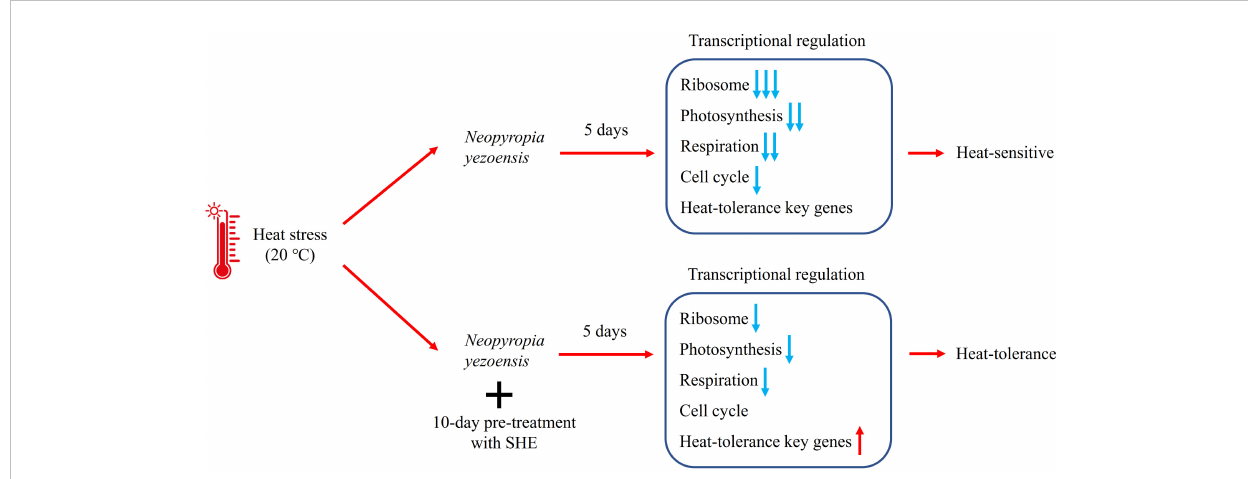
FIGURE 3 Scheme summarized the possible mechanisms of the different responses in Neopyropia yezoensis with or without SHE pre-treatment under heat stress. Blue arrows: down-regulation of genes; Red arrows: up-regulation of genes. Symbol +: Pretreatment of